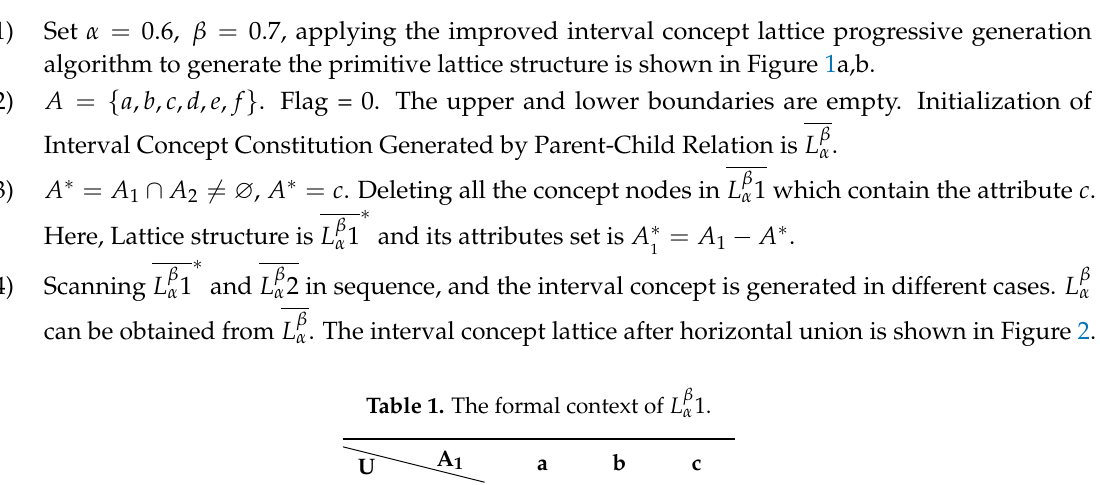
Table 1. The formal context of L β α 1.